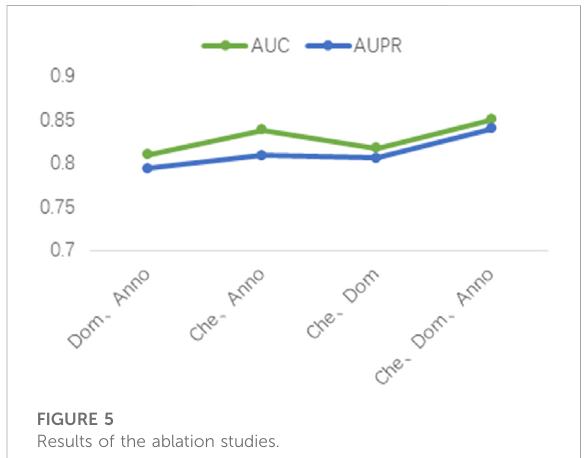
FIGURE 5 Results of the ablation